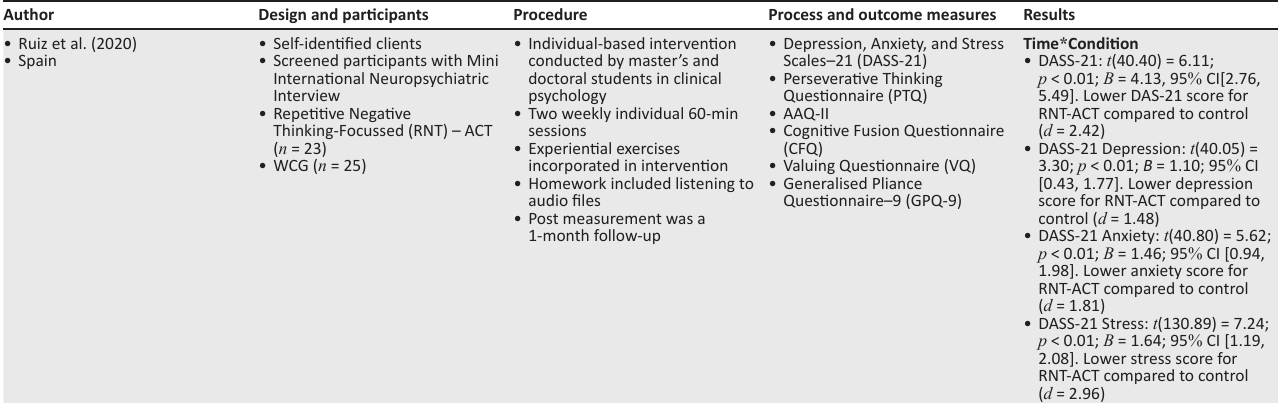
TABLE 3 (Continues...): Brief acceptance and commitment therapy